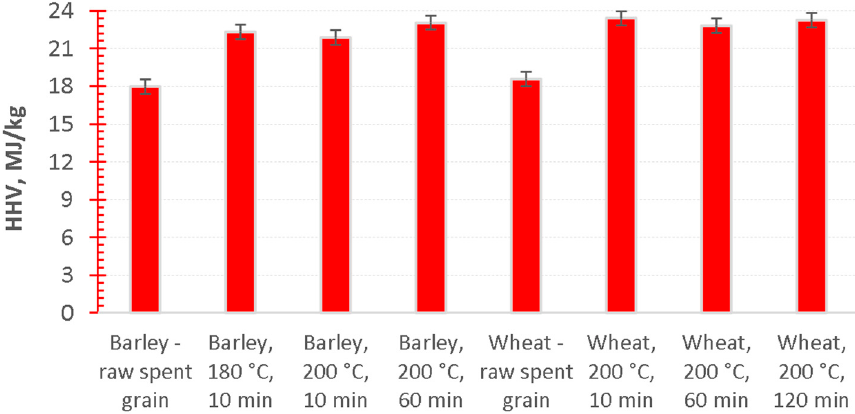
Figure 4. Higher heating value of feedstocks and respective hydrochars.